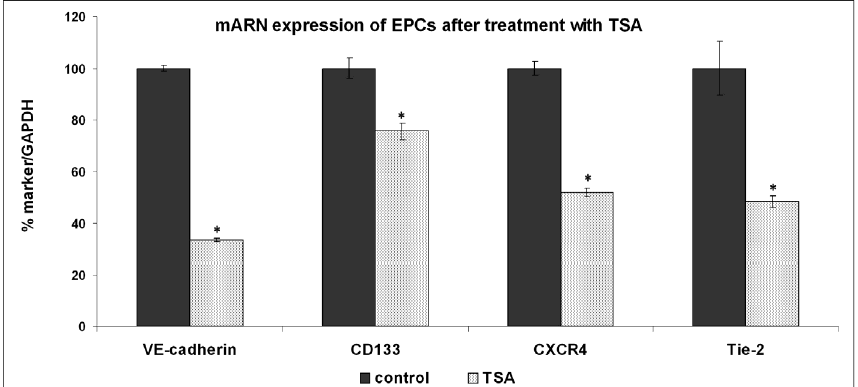
Figure 4. Effect of TSA (1 μ M) on mRNA expression of EPCs markers. The expression of VE-cadherin , CD133 , CXCR4 , and Tie-2 mRNA was significantly decreased. Results are represented as mean ± standard error, n = 3, * p <